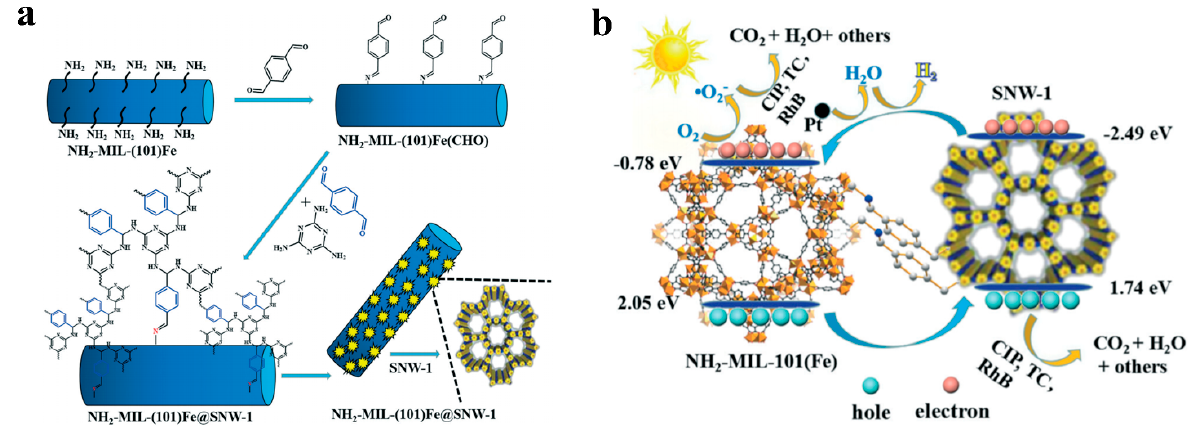
Figure 14. ( a ) The schematic illustration of the synthesis steps of the NH 2 -MIL-(101)Fe@SNW-1. ( b ) The mechanism diagram of photodegradation pollutant and photocatalytic H 2 evolution for MS-0.8 under the visible-light irradiation. Reproduced with permission from Ref. [81].